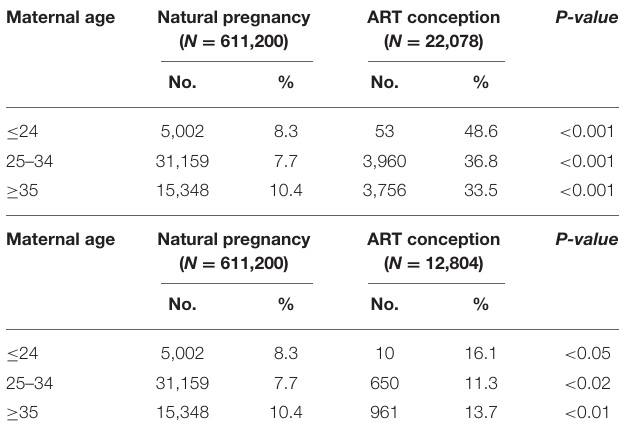
TABLE 3 | Proportion of preterm birth ( < 37 weeks) in natural pregnancy, ART conception and ART conception singleton in 2014–2016. Maternal age Natural pregnancy ( N =